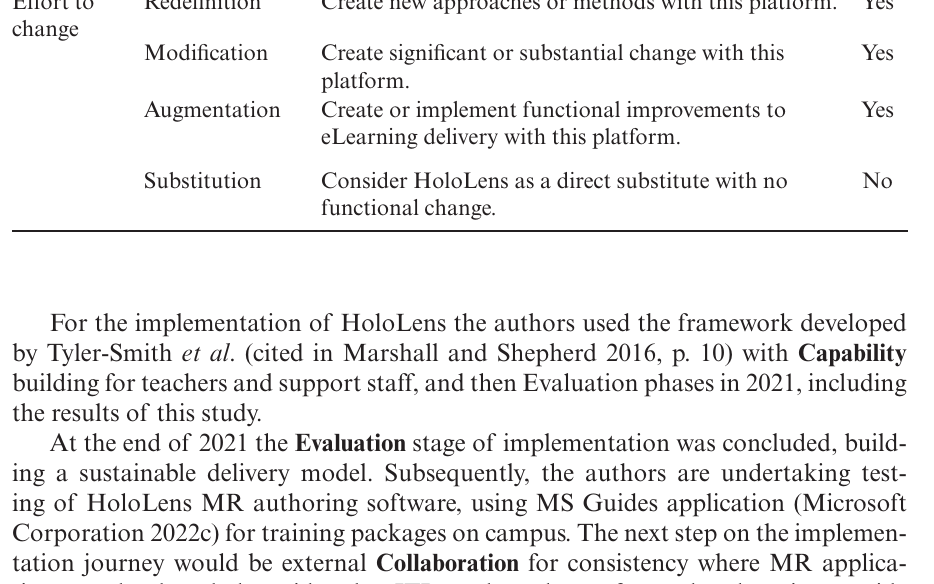
Table 2. Application of the Substitution Augmentation Modification Redefinition (SAMR) model. Effort to Redefinition Create new approaches or methods with this platform. Yes change Modification Create significant or substantial change with this platform. Augmentation Create or implement functional improvements to eLearning delivery with this platform. Substitution Consider HoloLens as a direct substitute with no functional change.